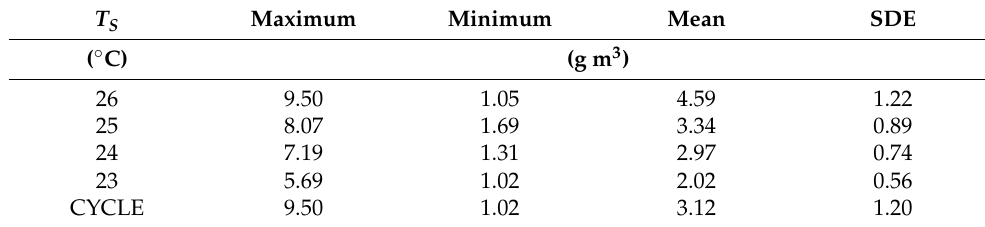
Table 3. Main statistics for CO 2 concentration in the building for different setpoint temperatures.